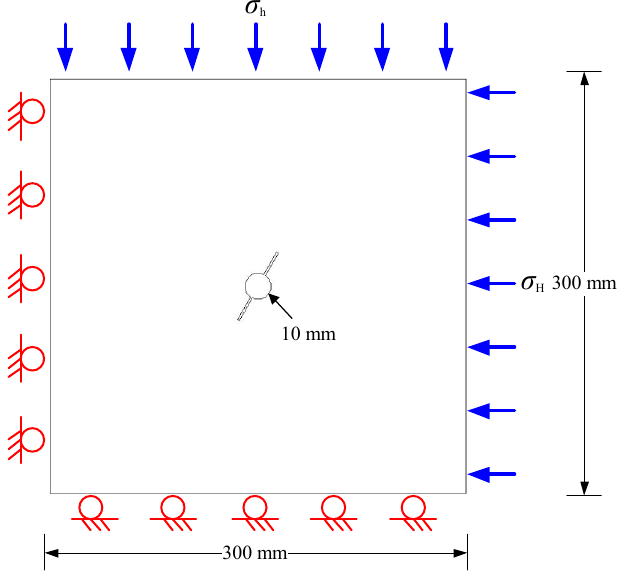
Figure 6. Geometry of the numerical model used to investigate near-wellbore hydraulic fracturing processes.